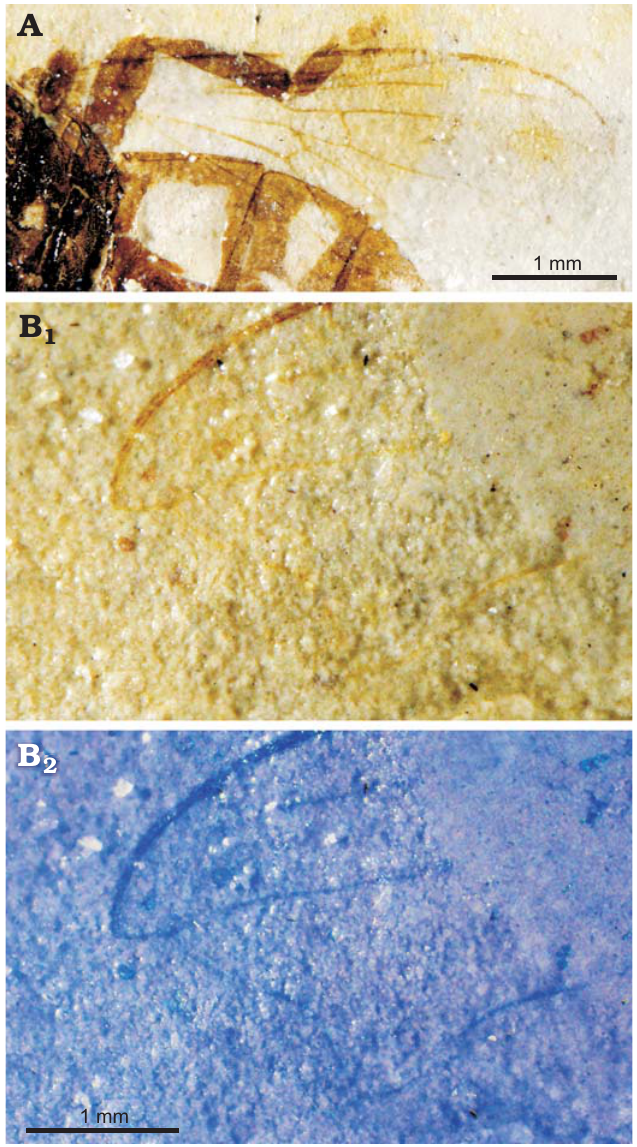
Fig. 5. Pipizine hoverfly Oligopipiza quadriguttata Nidergras, Hadrava, and Nel gen. et sp. nov., allotype RNGL-S10, Rupelian, Céreste, France. A . Wing. B . Wing apex, normal light photograph (B 1 ), treated to better show veins (B 2 ).